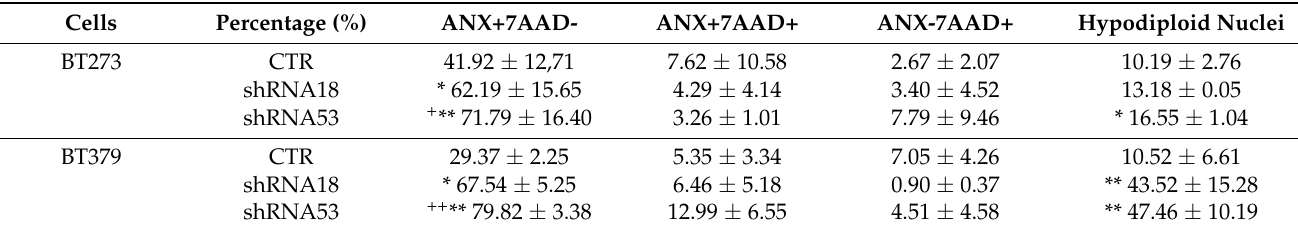
Table 1. Percentage of Annexin V (ANX), 7-amino actinomycin D (7-AAD), ANX/7AAD)-positive, and percentage of Hypodiploid nuclei in BT273 or BT379 GSCs transduced with shRNA18 or shRNA53 and analysed by Flow